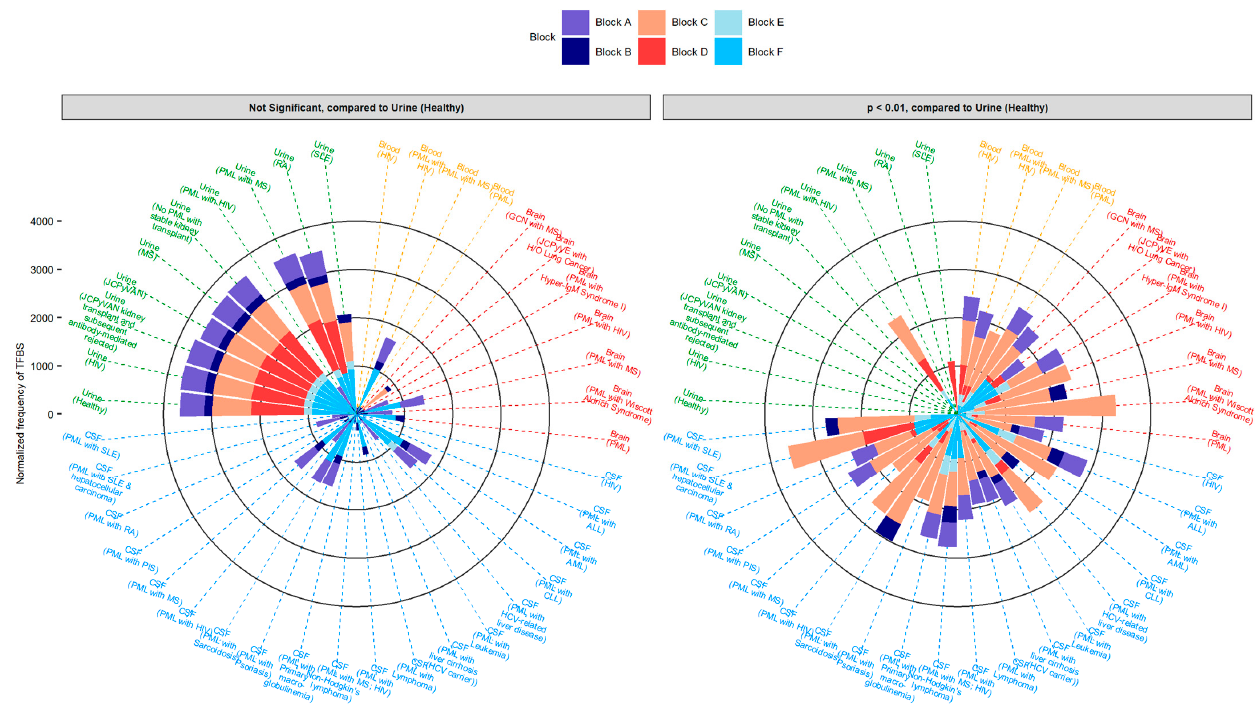
Figure 3. Blocks C, D, and F of the JCPyV NCCR have the largest variation in the frequency of TFBS in sequences isolated from the brain, plasma, and CSF of diseased individuals compared to sequences isolated from the urine of healthy individuals. The overall distribution of the normalized frequency of TFBS [(# of TFBS/Block)/(# of sequences)] were plotted based on disease status and tissue source using the R package, ‘ggplot2’. Adjusted p values were determined using either the chi square test adjusting the p values using the Bonferroni method or using the fisher exact test, adjusting the p values using the Benjamini-Hochberg (BH) method. The selection of these statistical tests was determined by group size and compared the number of normalized frequencies of TFBS ( y -axis) within each block from the Urine (Healthy) to all other